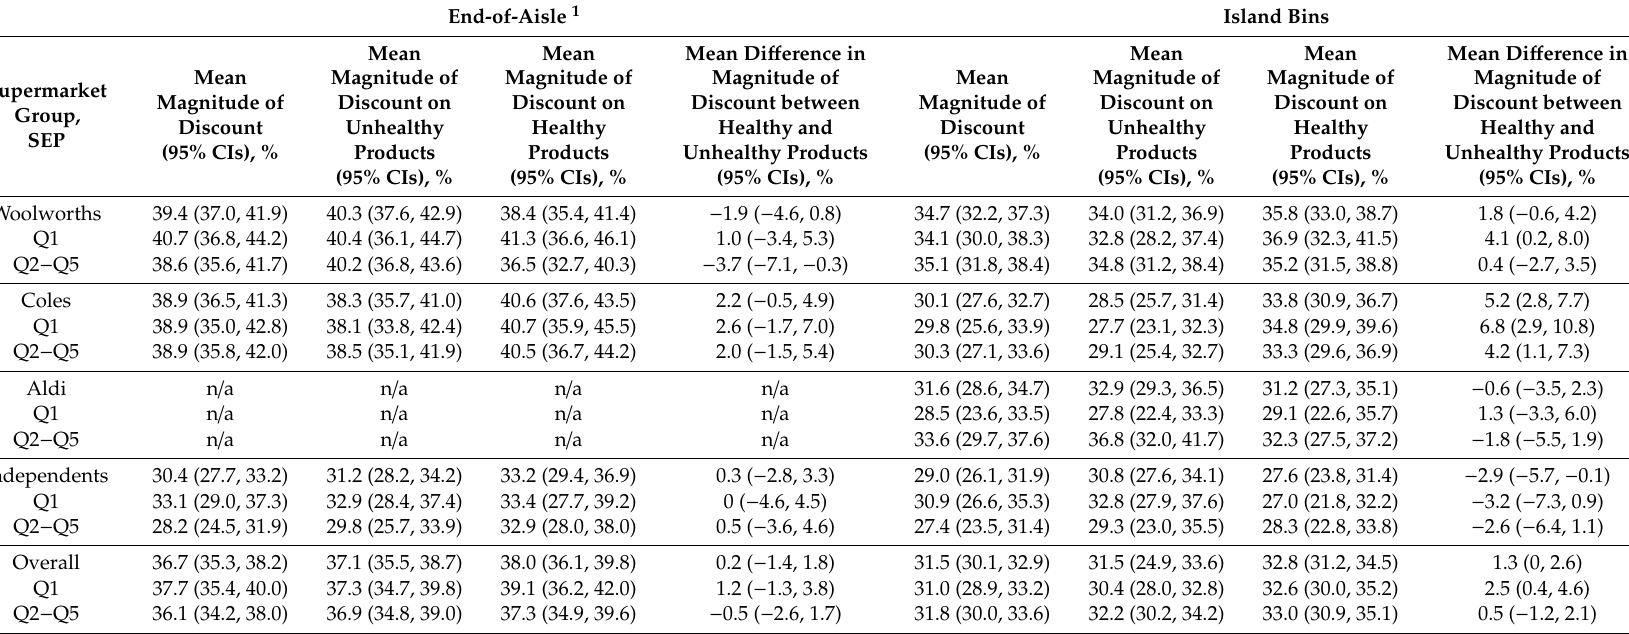
Table 4. Mean magnitude of discount on food and beverage price promotion at prominent in-store supermarket locations. End-of-Aisle 1 Island